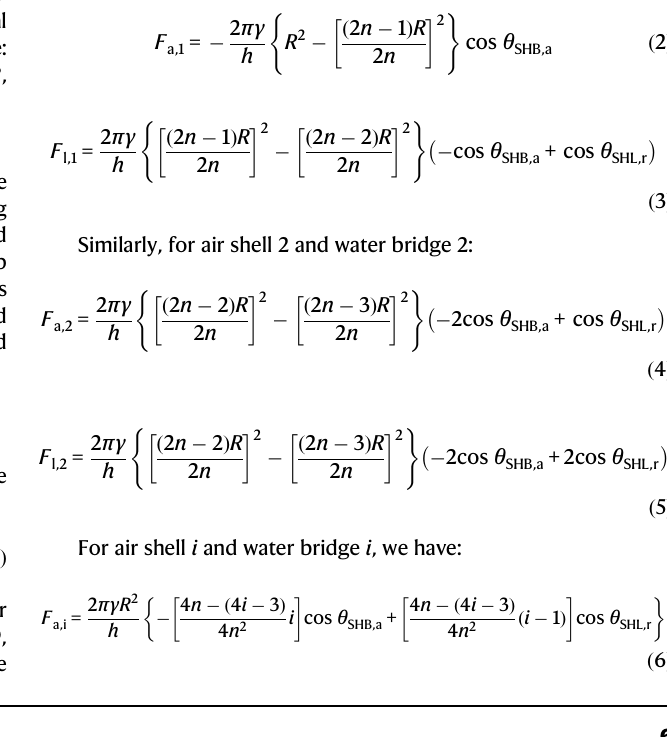
b Selected snapshots showing the on-demand pick-up and release of non- conductive glass cylinder by applying the fl exible adhesives between the glass cylinder and its counterpart. Scale bar: